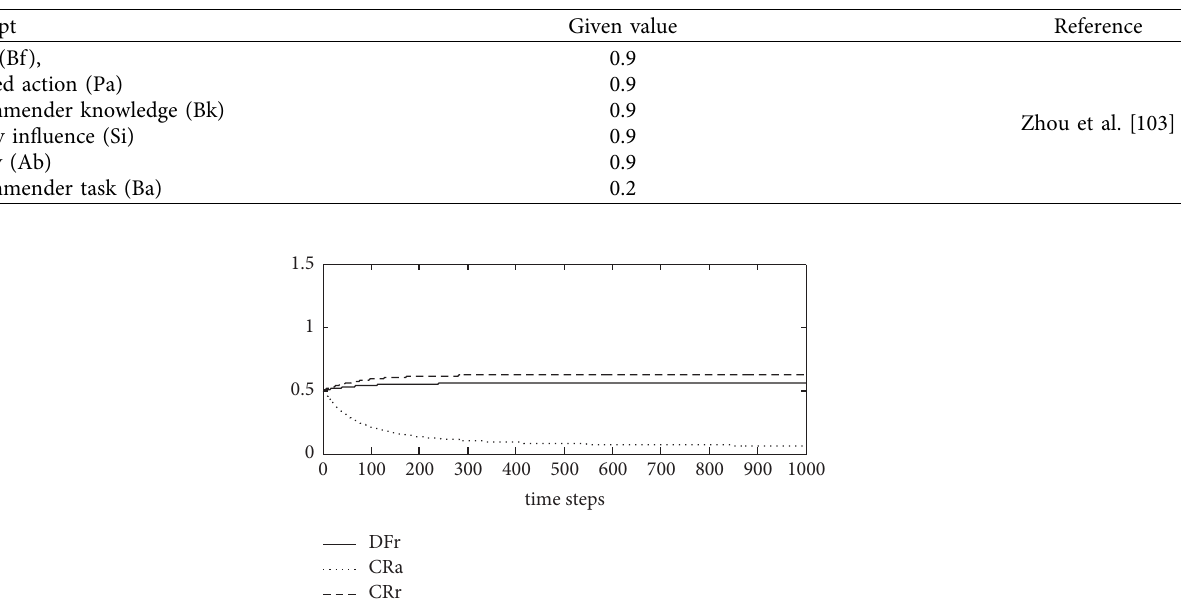
Figure 7: Te task challenging case simulation. Table 4: Values of the infuential case.